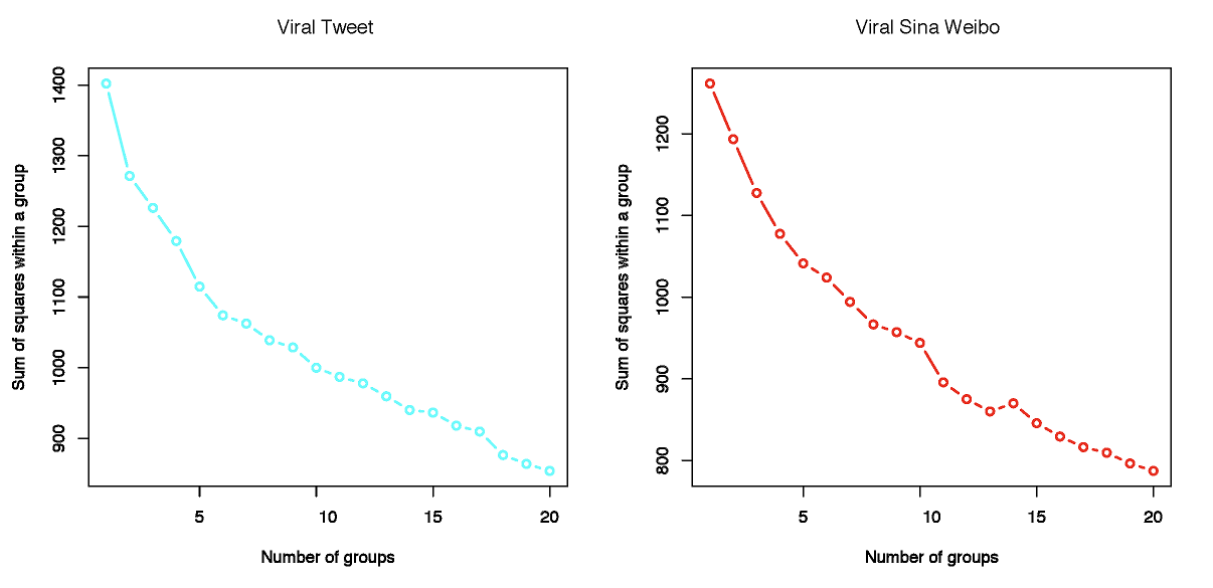
Figure 5. Numbers of clusters and within-group sums of squares for tweets (left) and Weibo posts (right).